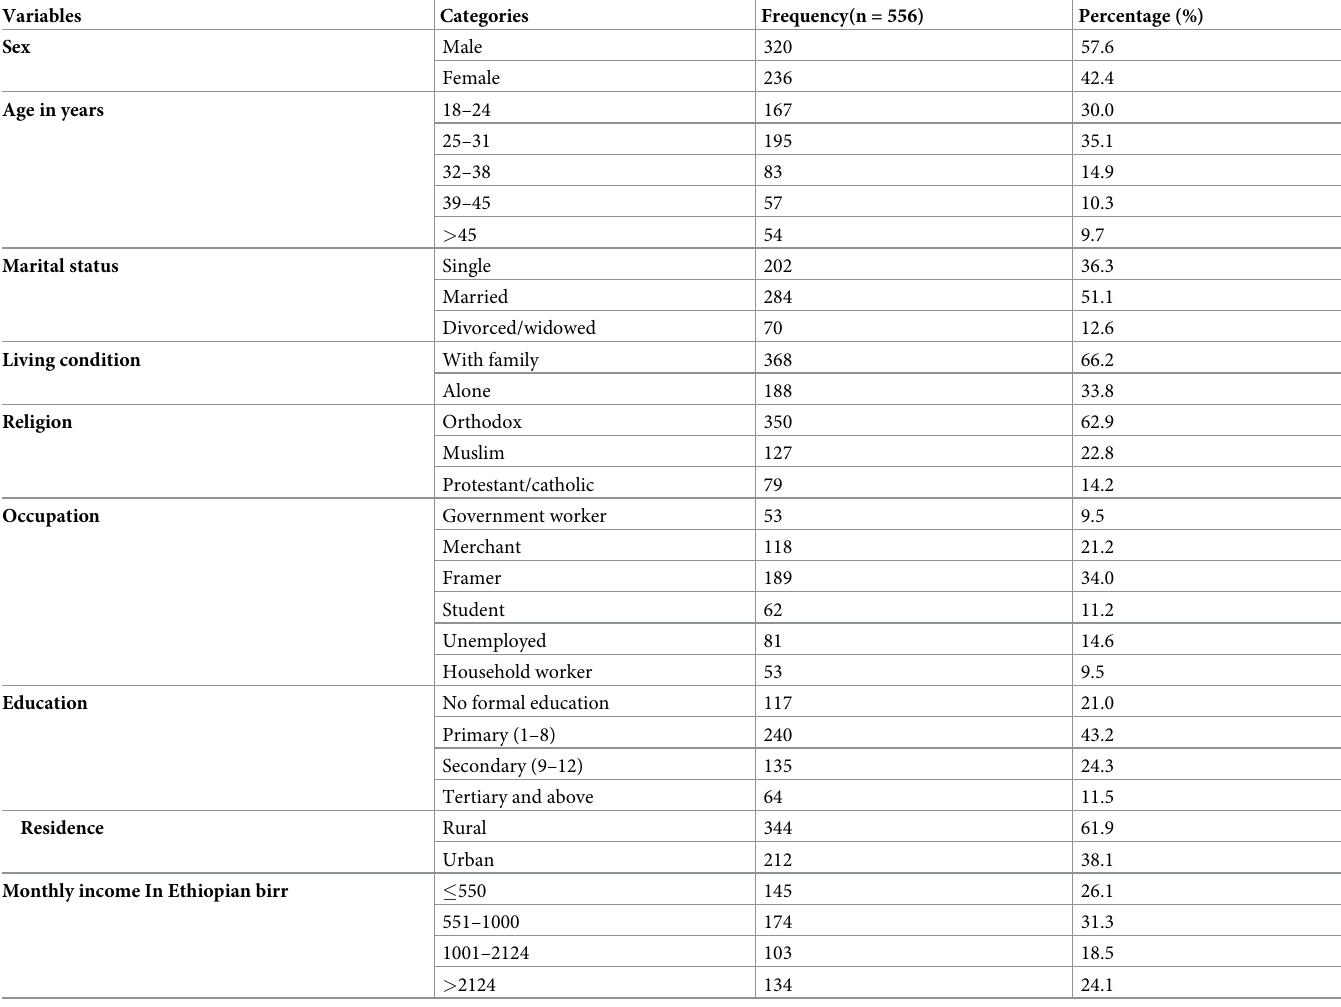
Table 1. Socio-demographic and economic distributions of people with epilepsy at central Gondar zone primary public hospitals, northern part Ethiopia (n =